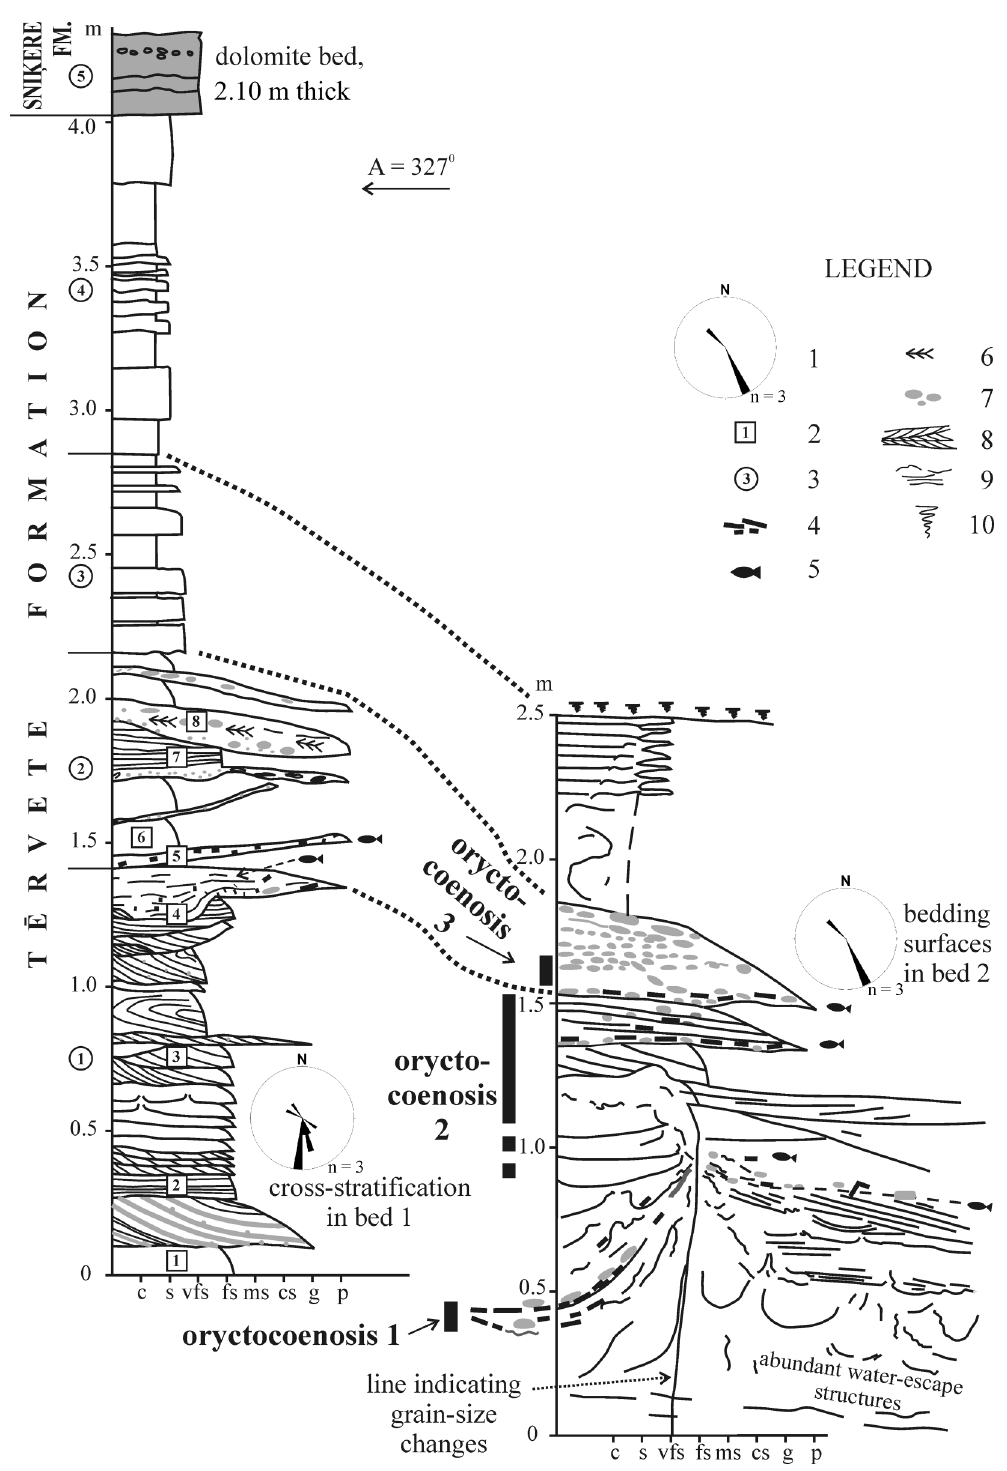
Fig. 2. Geological section of the Kl ū nas outcrop, T ē rvete Formation. Grain size of siliciclastics: c, clay; s, silt; vfs, very fine- grained sand; fs, fine-grained sand; ms, medium-grained sand; cs, coarse-grained sand; g, gravel; p, pebbles. 1, rose diagrams, showing the cross-stratification dip azimuth for bed 1 ( n = 10) and bedding surface dip azimuth for bed 2 ( n = 3); 2, sampling site; 3, bed number; 4, vertebrate remains and their position; 5, intervals of the geological section where vertebrate remains have been found; 6, plant remains; 7, clay clasts; 8, cross-stratification; 9, various sedimentary structures, and post-depositional deformations; 10,